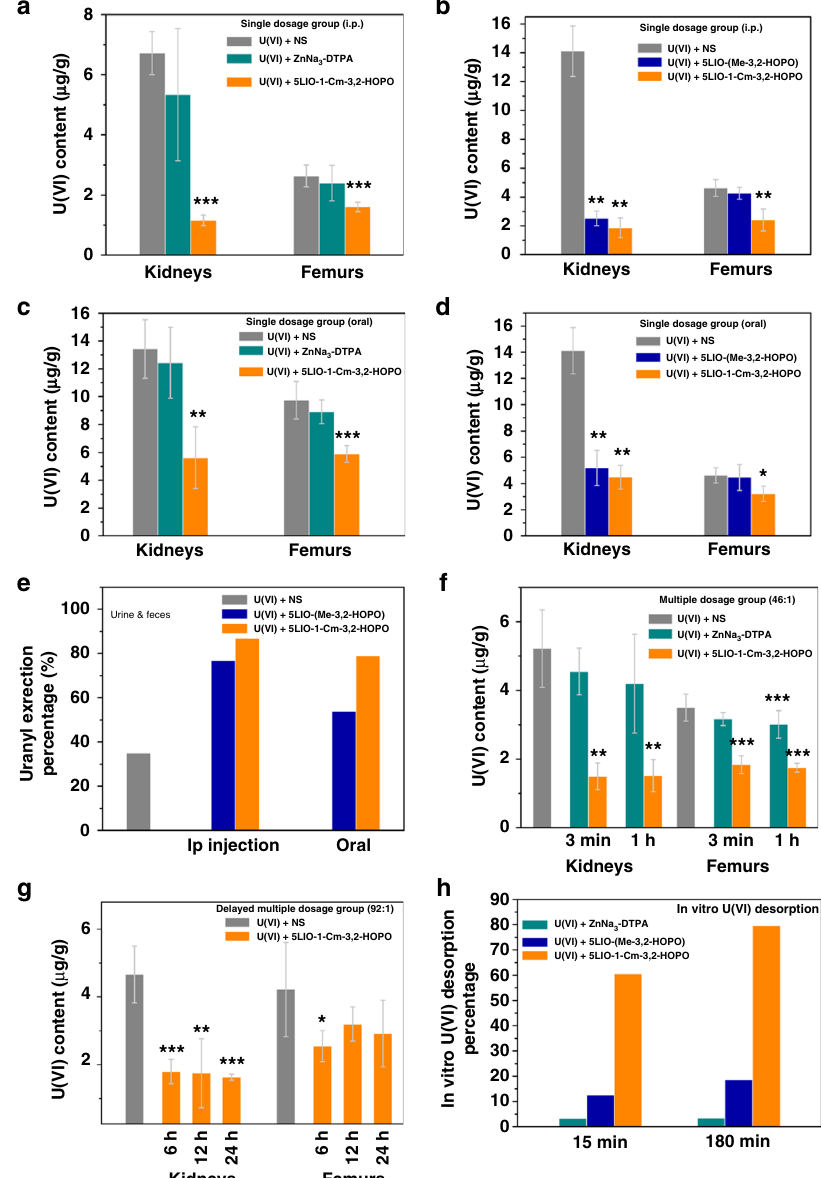
Fig. 6 In vivo decorporation ef fi ciency and in vitro desorption ef fi ciency results. a – d Removal ef fi ciency of U(VI) deposited in the kidneys and femurs compared to the control group. For the single-dose group, mice were ip injected (193 μ mol kg − 1 , molar ratio 92:1) or oral administered (644 μ mol kg − 1 , molar ratio 307:1) with ligands after the iv injection of U(VI) (0.5 mg U(VI) kg − 1 ) and then were killed 24 h later. e The urine & feces excretion percentage for the group 5LIO-1-Cm-3,2-HOPO and 5LIO-(Me-3,2-HOPO) treated with single-dose ip injection or oral administration. f Removal ef fi ciency of U(VI) deposited in the kidneys and femurs compared to the control group, for the multiple-dose group. Mice were given the ligand by ip (97 μ mol kg − 1 , molar ratio 46:1) injection at 3 min, 6 h, 24 h, and 48 h, or at 1 h, 7 h, 25 h, and 49 h after the iv injection of U(VI) (0.5 mg U(VI) kg − 1 ) and were killed 72 h later. g Removal ef fi ciency of U(VI) deposited in the kidneys and femurs compared to the control group, for the delayed multiple-dose group. Mice were given the ligand by ip (193 μ mol kg − 1 , molar ratio 92:1) injection at 6 h, 12 h, 30 h, and 54 h (6 h delayed multiple-dose group), or at 12, 18, 36, and 60 h (12 h delayed multiple-dose group), or at 24, 30, 48, and 72 h (24 h delayed multiple-dose group) after the iv injection of U(VI) (0.5 mg U(VI) kg − 1 ) and were killed 7 d later. * p < 0.05, ** p < 0.01, *** p < 0.001 vs. U(VI)-treated control, paired-sample T-test for independent-samples, n = 5 mice. Bars indicate SD, n = 5 mice. h U(VI) desorption ef fi ciency from HAP using 5LIO-1-Cm-3,2-HOPO, 5LIO-(Me-3,2-HOPO) or ZnNa 3 -DTPA. Source data are provided as a Source Data fi